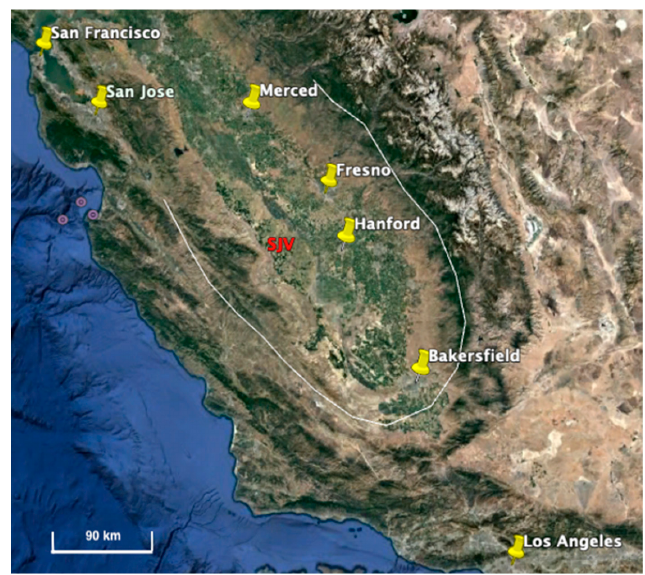
Figure 1. Location of San Joaquin Valley (SJV), Fresno, and a few other cities in the lower portion of central California. Meteorology has a strong effect on the chemistry of NH 4 NO 3 formation. To form NH 4 NO 3 particles, oxides of nitrogen (NO X ) must be converted to nitric acid (HNO 3 ) through photochemical processes and through nighttime gas-phase and heterogeneous chemistry. Photochemical reactions during the day produce the hydroxyl radical (HO), and the reaction of NO 2 with HO is the most important source of HNO 3 formation during the daytime [11]. Gaseous ammonia (NH 3 ) and gaseous HNO 3 react to form ambient particulate NH 4 NO 3 . NH 3 (g) + HNO 3 (g) ⇔ NH 4 NO 3 (g) NH 4 NO 3 (g) ⇔ NH 4 NO 3 (s) This equilibrium depends on temperature and relative humidity (RH; [12]). Increasing temperature leads to an increasing rate of dissociation of NH 4 NO 3 (s) and remains constant for a given temperature below deliquescence RH [13]. Above the deliquescence RH, increasing RH leads to rapid decreases in dissociation.